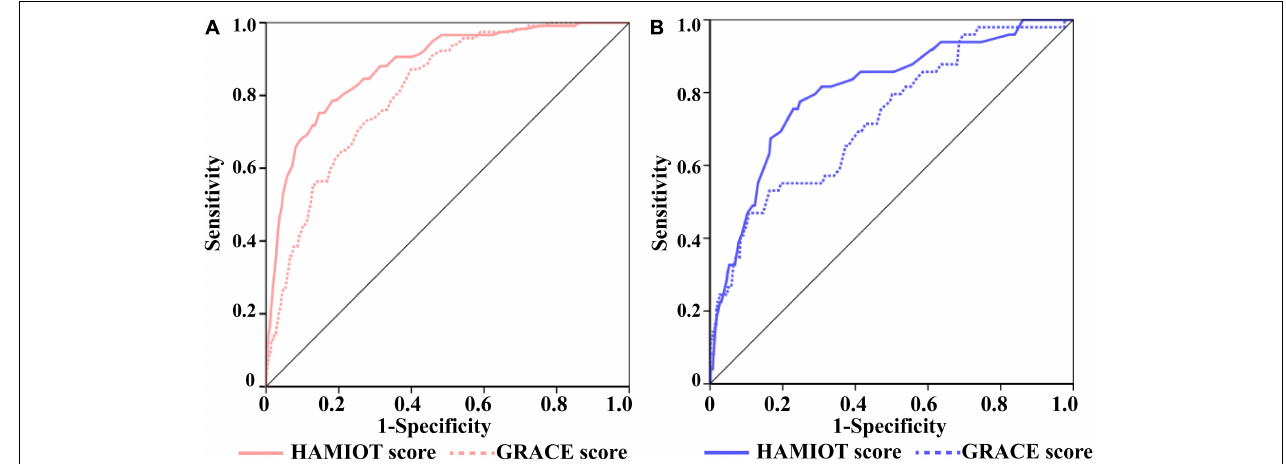
FIGURE 4 | The ROC Curves of the HAMIOT and the GRACE risk score. (A) In the training cohort, the c-statistic in the HAMIOT score 0.88(0.84,0.91) was higher than the GRACE score 0.81(0.77,0.84). (B) In the validation cohort, the c-statistic in the HAMIOT score 0.82(0.76,0.88) was higher than the GRACE 0.72(0.65,0.8). HAMIOT, the Heart failure after Acute Myocardial Infarction with Optimal Treatment; GRACE, the Global Registry of Acute Coronary Events; ROC, receiver operating characteristic.